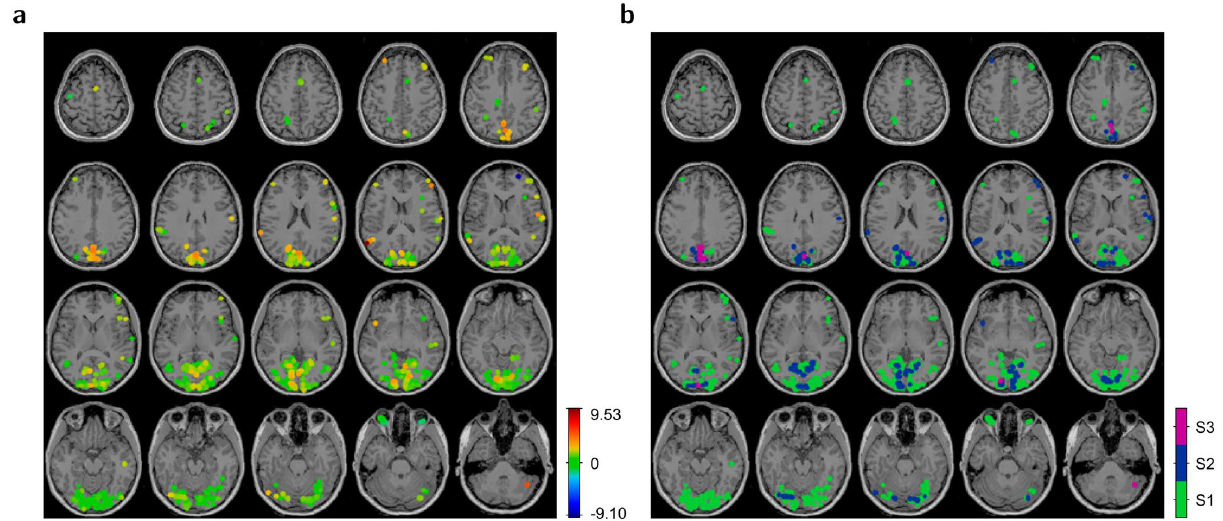
Figure 4. Optimized latency in a native brain. ( a ) Latency map for voxels from the subsets S1–S3 as defined in Fig. 3. The color bar shows latency in seconds, ( b ) Subset map. Pixels were dilated by a disk with a radius of 4 mm, for better